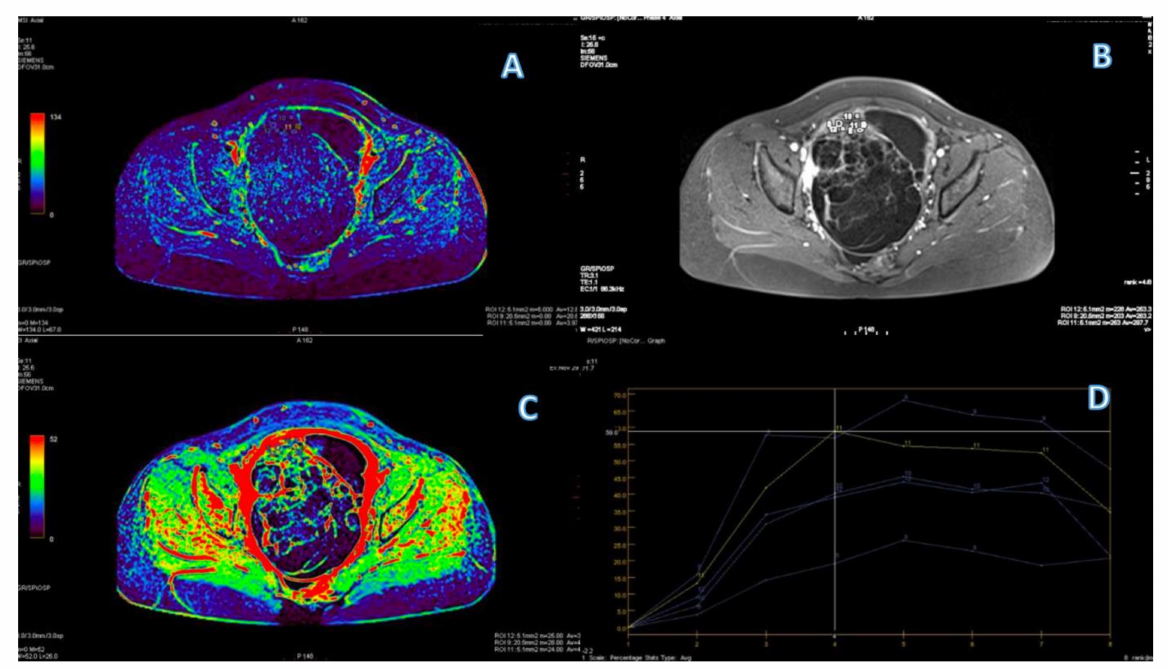
Figure 6. Images from the same 24-year-old woman with mucinous ovarian cancer. Dynamic contrast enhancement and small ROI on intratumoral vessels. ( A – C ) Contrast enhancement curves ( D ).